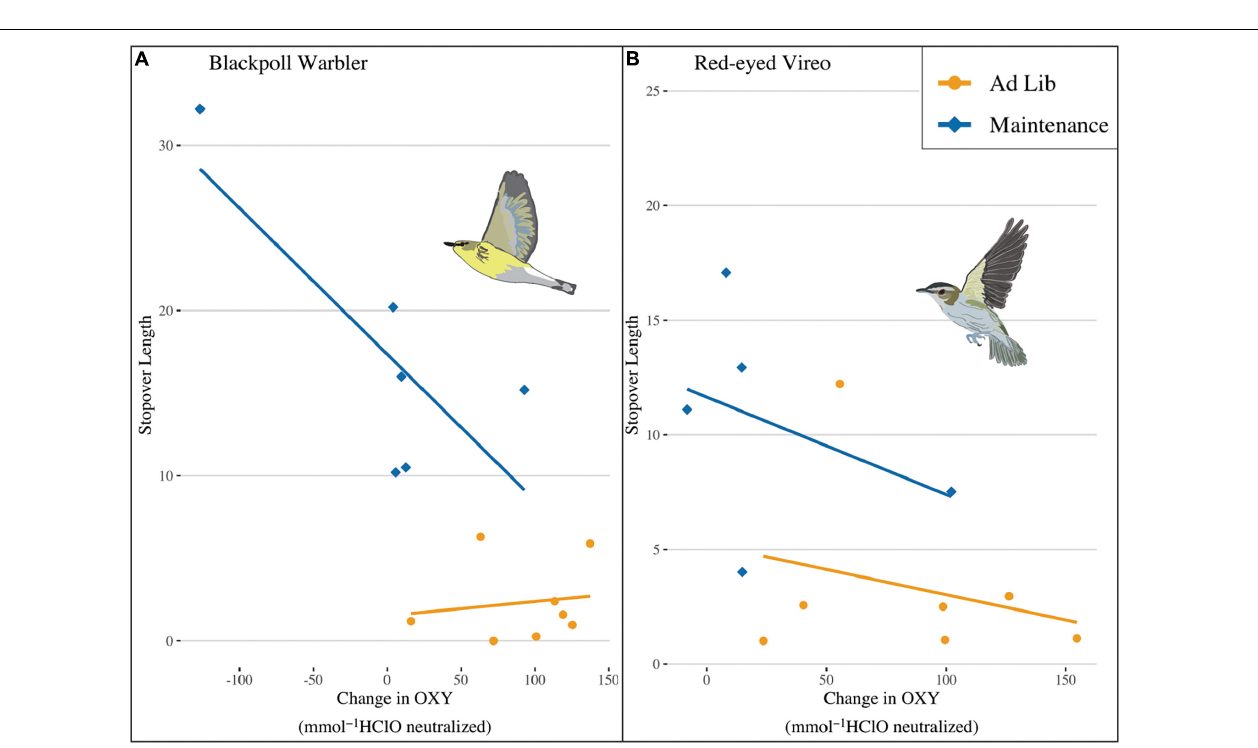
FIGURE 6 | Relationship between non-enzymatic antioxidant capacity during captivity (blood sample prior to release—blood sample at capture) and days spent on stopover after release for (A) Blackpoll Warblers fed ad lib (gold circles) or at maintenance levels (light blue diamonds). (B) Red-eyed Vireos fed ad lib (gold circles) or at maintenance levels (light blue diamonds). There were no significant relationships for Hermit Thrush or Yellow-rumped Warblers (not shown, see text for details).